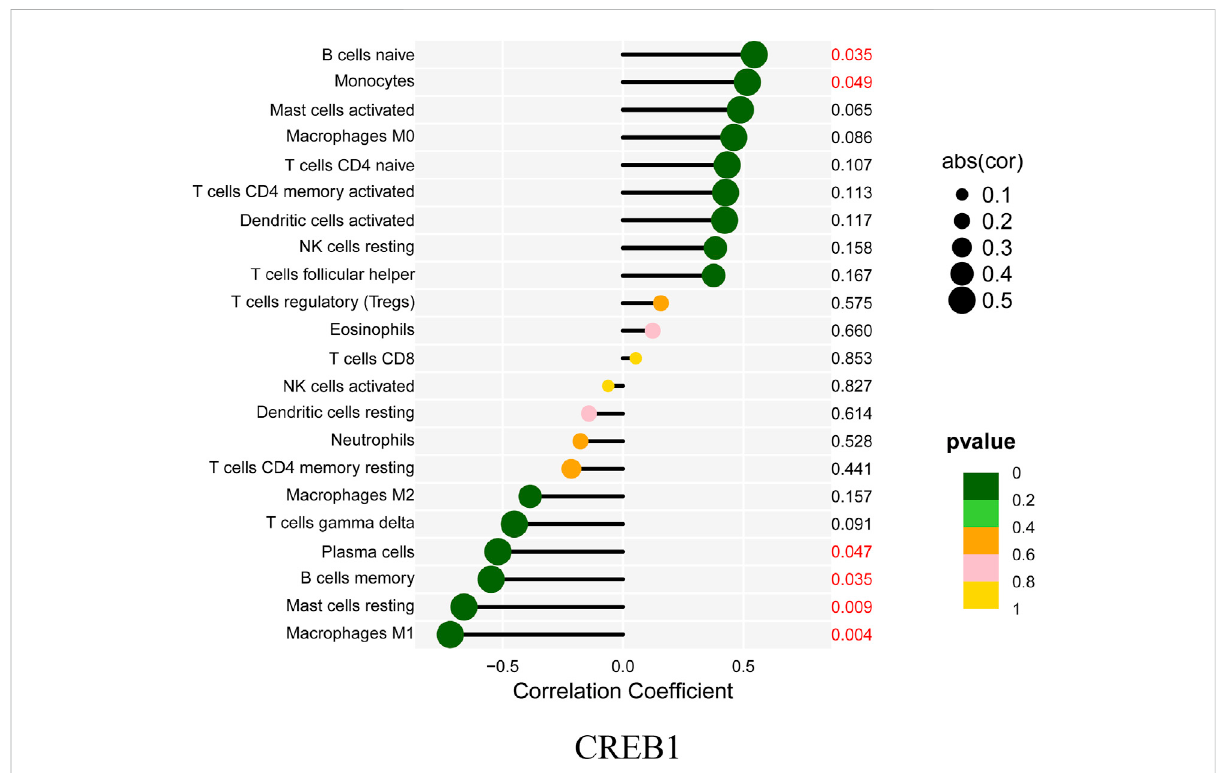
FIGURE 9 Correlation between CREB1 and in fi ltrating immune cells. The size of each dot is positively correlated with the strength of the correlation between genes and immune